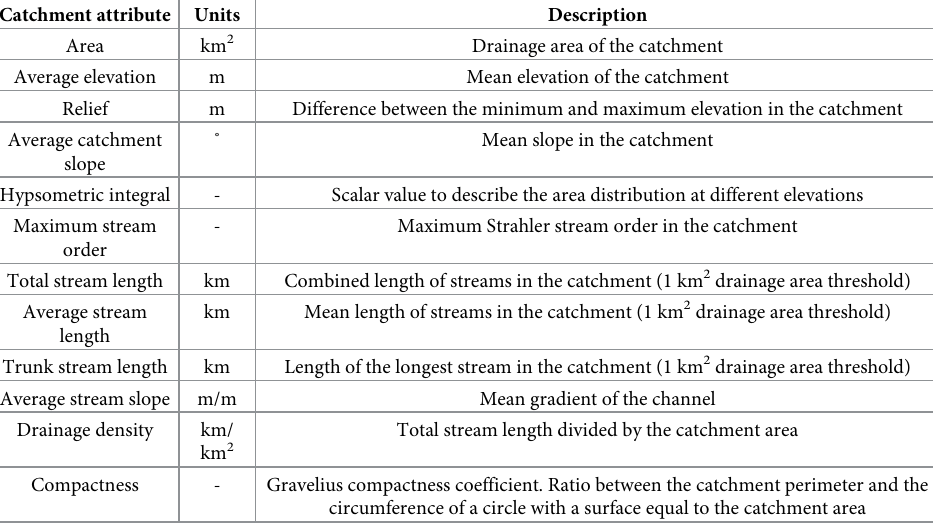
Table 2. Selected attributes included in the ArcGIS